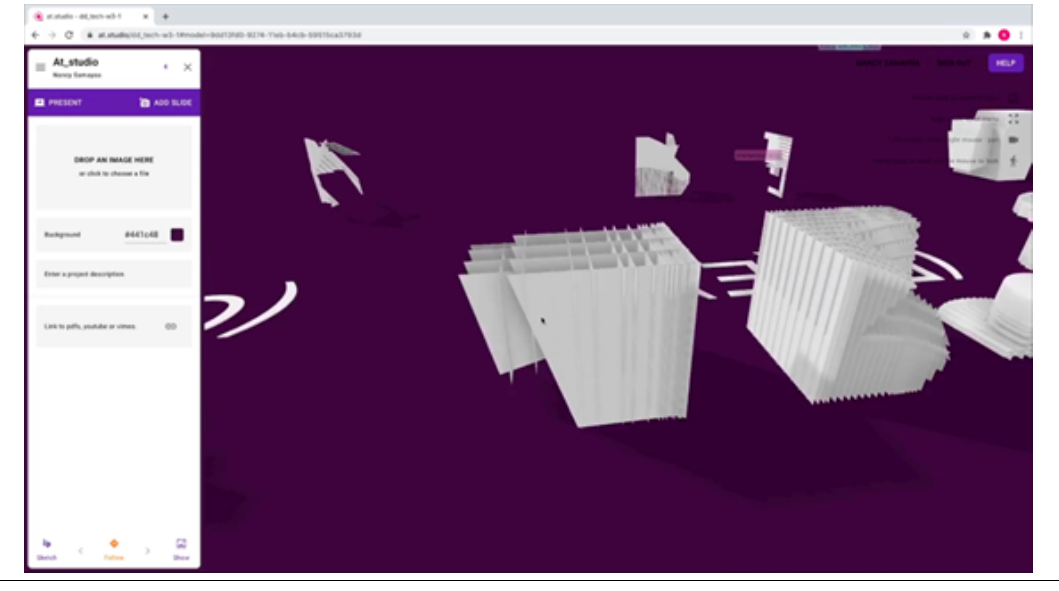
Figure 6. A virtual environment for students to interrogate 3D concept models (at.studio) (Source: Nancy Samayoa, 2021)